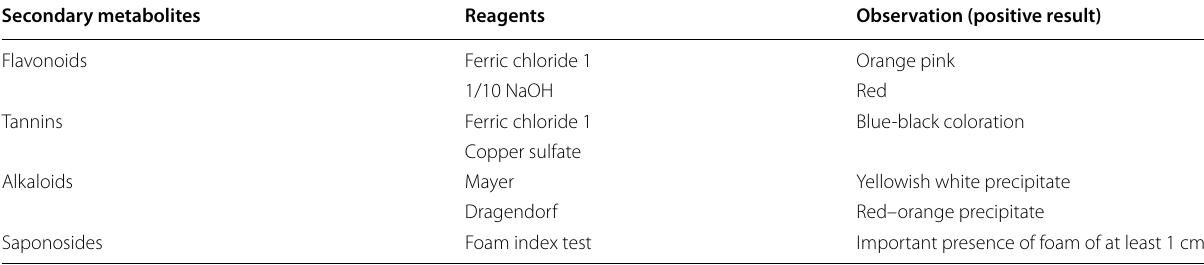
Table 1 Chemical compounds sought in the hydroalcoholic extract of H.